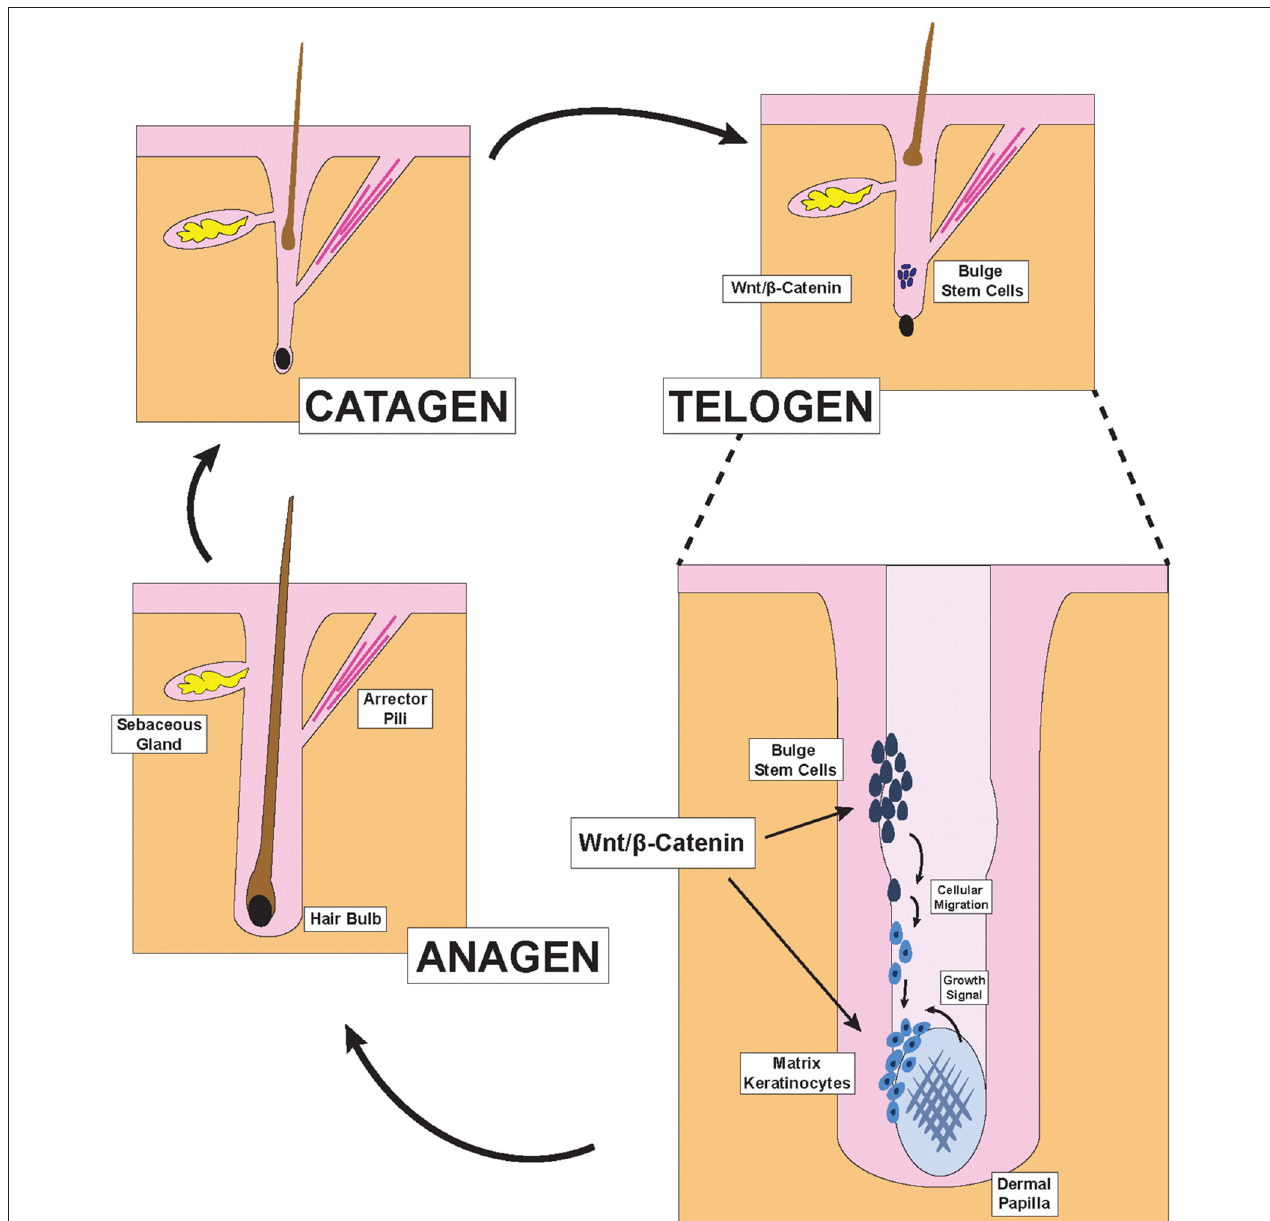
FIGURE 1 | Hair Follicle structures and phases of the hair cycle. Illustration depicting pertinent structures of the hair follicle as well as the effect of Wnt/ β -catenin signaling on hair formation. During the late telogen/early anagen phase, molecular signals from the dermal papilla promote the migration and differentiation of bulge stem cells to form new matrix keratinocytes of the anagen